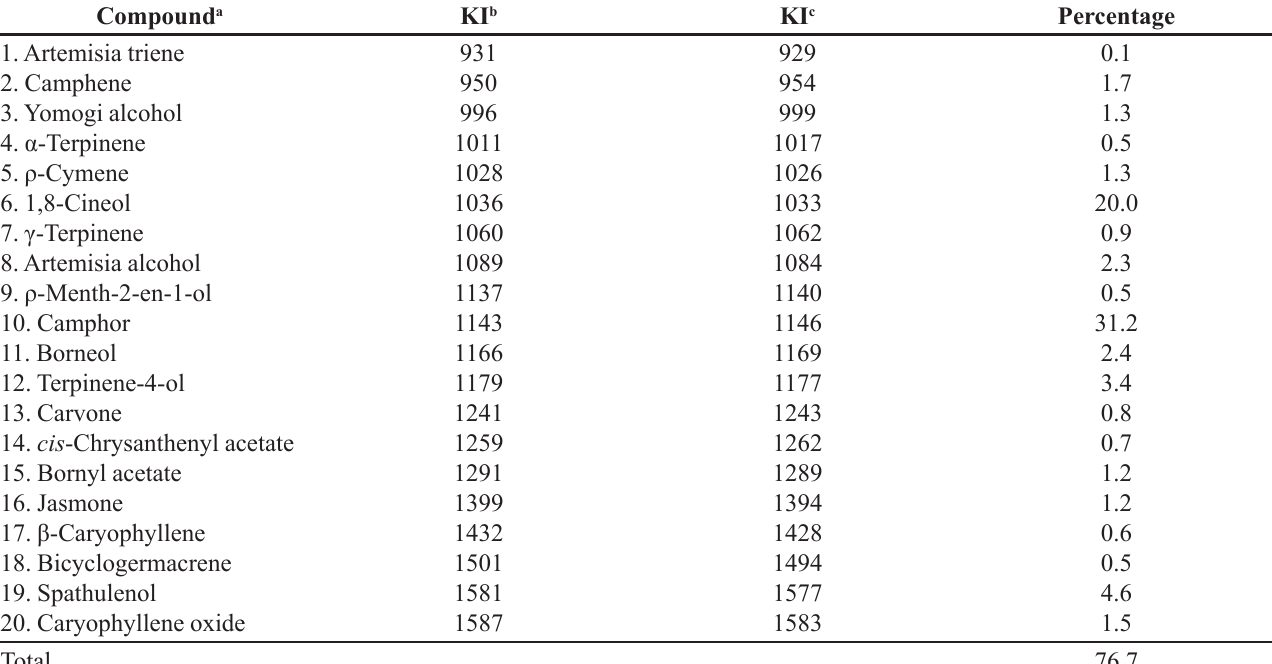
TABLE II - GC-MS analysis of A. sieberi essential oil Compound